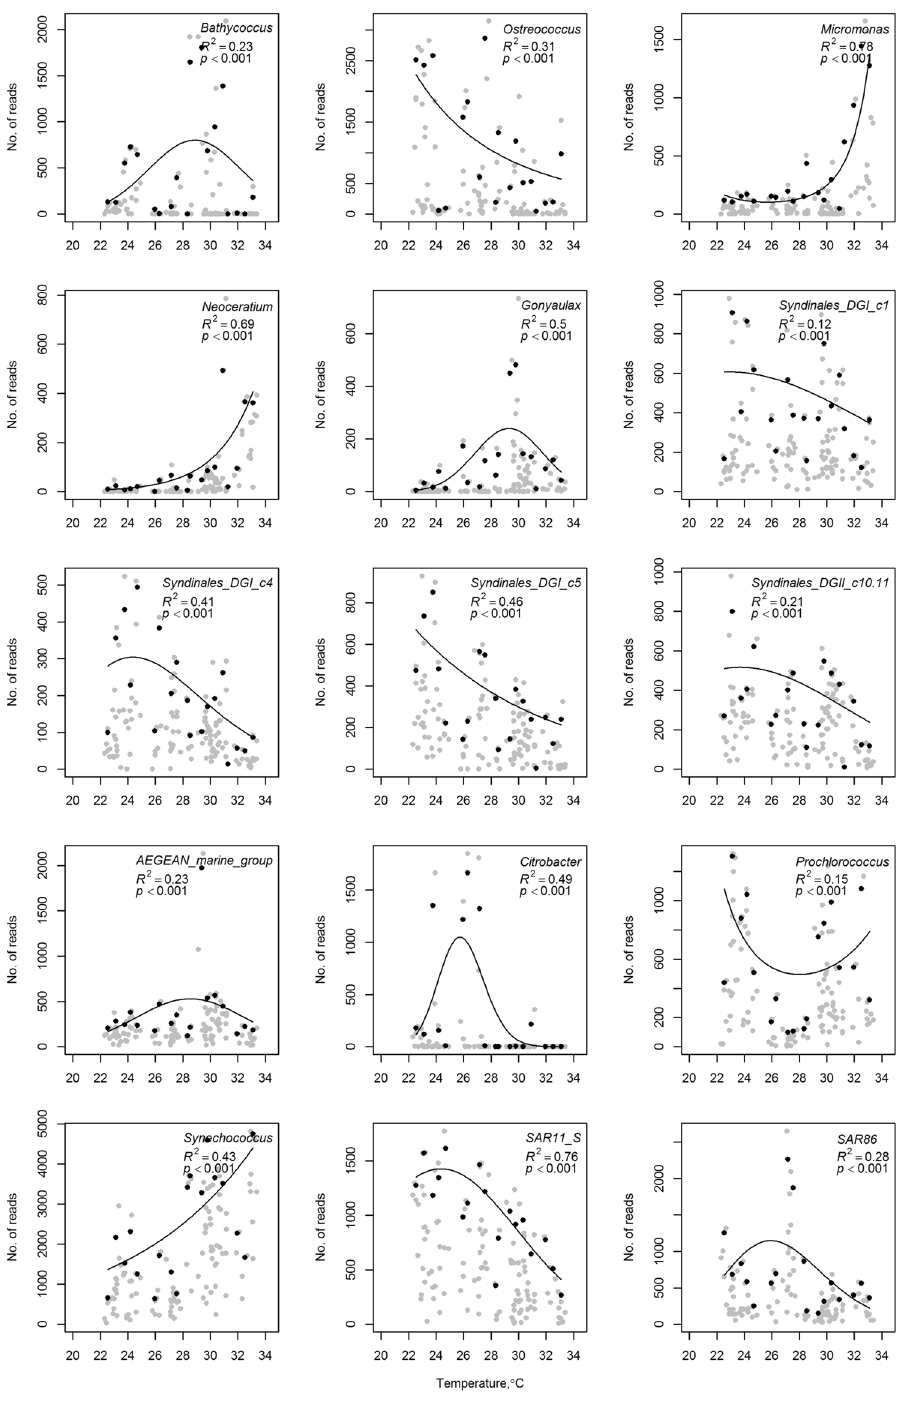
Figure 5. Maximum abundance models for various taxa against temperature. Grey points represent the data while black dots are the 95 th percentile of the maximum